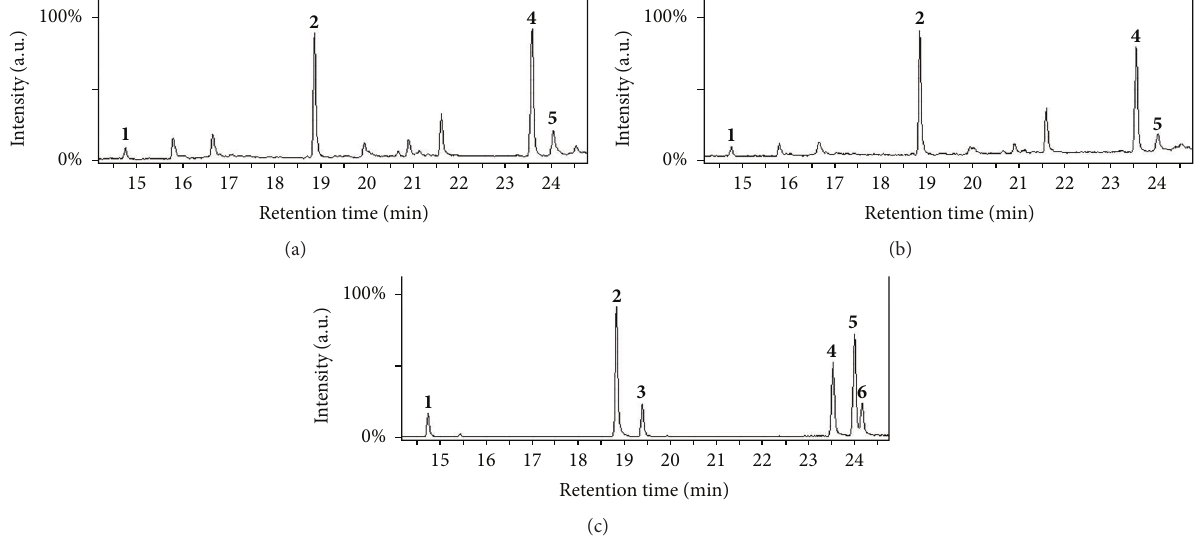
Figure 3: GC-MS analysis of fatty acids from cell extracts of I. hospitalis and I. hospitalis-N. equitans coculture. Total Ion Chromatograms (TICs) of fatty acids present in I. hospitalis cell extracts (a), I. hospitalis-N. equitans coculturecell extraction (b), and lipid standard (c) as analyzed by GC-MS. Four lipids were positively identified from this analysis, matching retention times of known standards and fragmentation patterns in the NIST database. GC peaks are labeled as follows: 1 , tetradecanoic acid (C14:0); 2 , hexadecanoic acid (C16:0); 3 , hexadecenoic acid (C16:1); 4 , octadecanoic acid (C18:0); 5 , octadecenoic acid (C18:1); and 6 , octadecadienoic acid